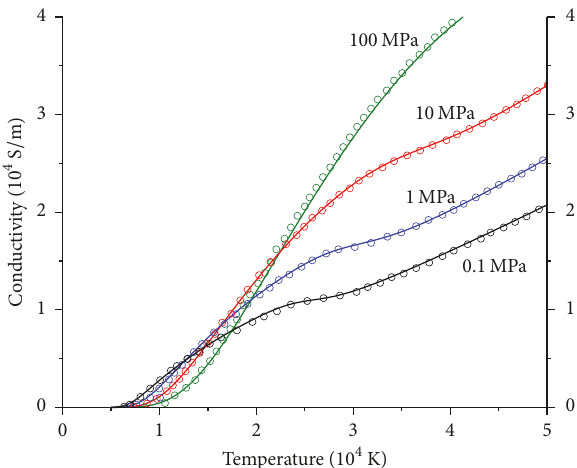
Figure1:Schematicdiagramofthemethodofsettingiterativeinitial value. Figure 2: Calculated conductivity for the polyethylene plasma as